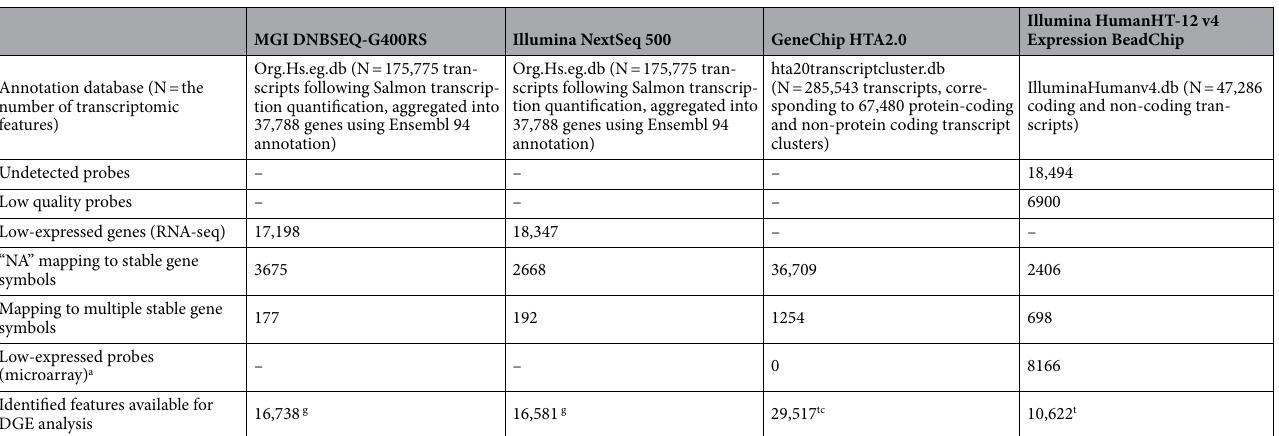
Table 2. Transcript annotation and filtering of the RNA-seq and microarray data prior to the DGE analysis. NA: features with no gene symbols returned after annotation. DGE: differential gene expression. –: not applicable. a Low expressed probes were further removed following assessing the average log expression and the mean–variance relationship after fitting the linear model in limma microarray analysis. g: protein-coding gene features. tc: protein-coding and non-protein coding transcript clusters, loosely corresponding to genes. t: coding and non-coding transcript